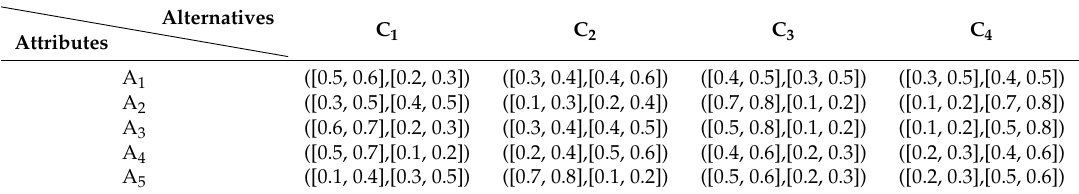
Table 2. Interval-valued intuitionistic fuzzy decision matrix (cid:60)